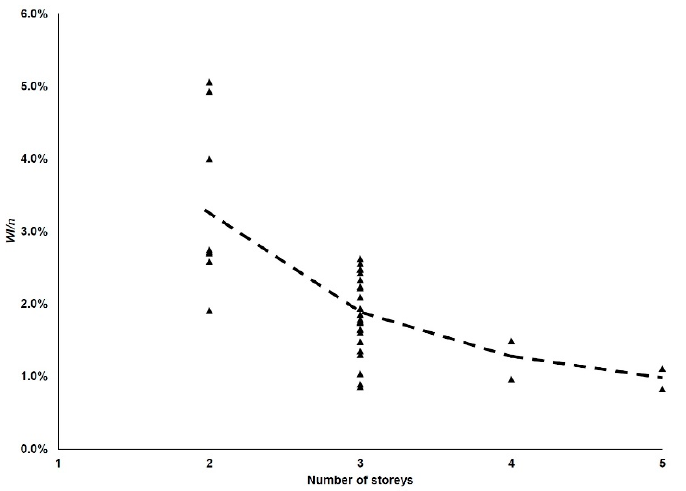
Figure 6. Distribution of WI/n values depending on the number of storeys (based on two WI/n values per building).